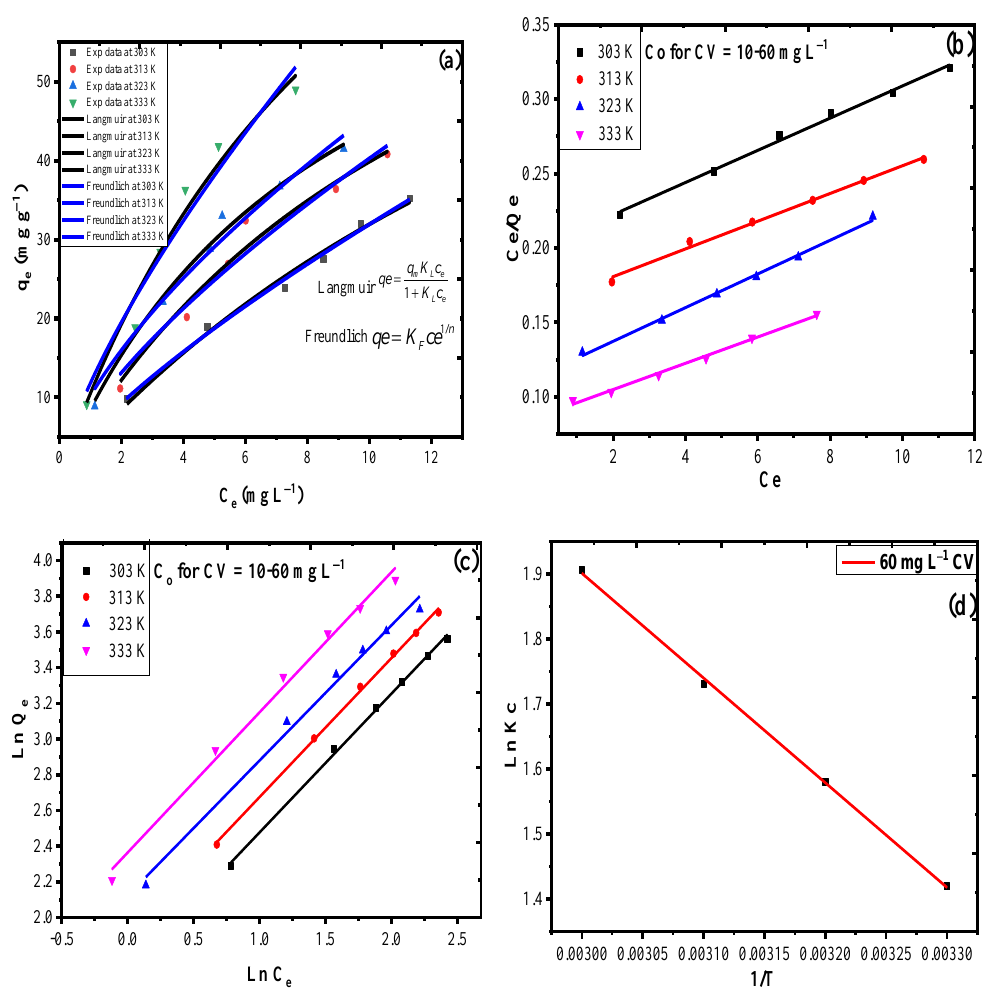
Figure 7. ( a ) Ce vs. q e plot for adsorption isotherm data. Linear regression plots for ( b ) Langmuir, ( c ) Freundlich and ( d ) Ln Kc vs. 1 / T thermodynamic plot at 303–333 K. Table 2. Adsorption isotherm parameters obtained for the adsorption reaction of CV with AS-g-PAni@MS nanocomposite at 303–333 K.